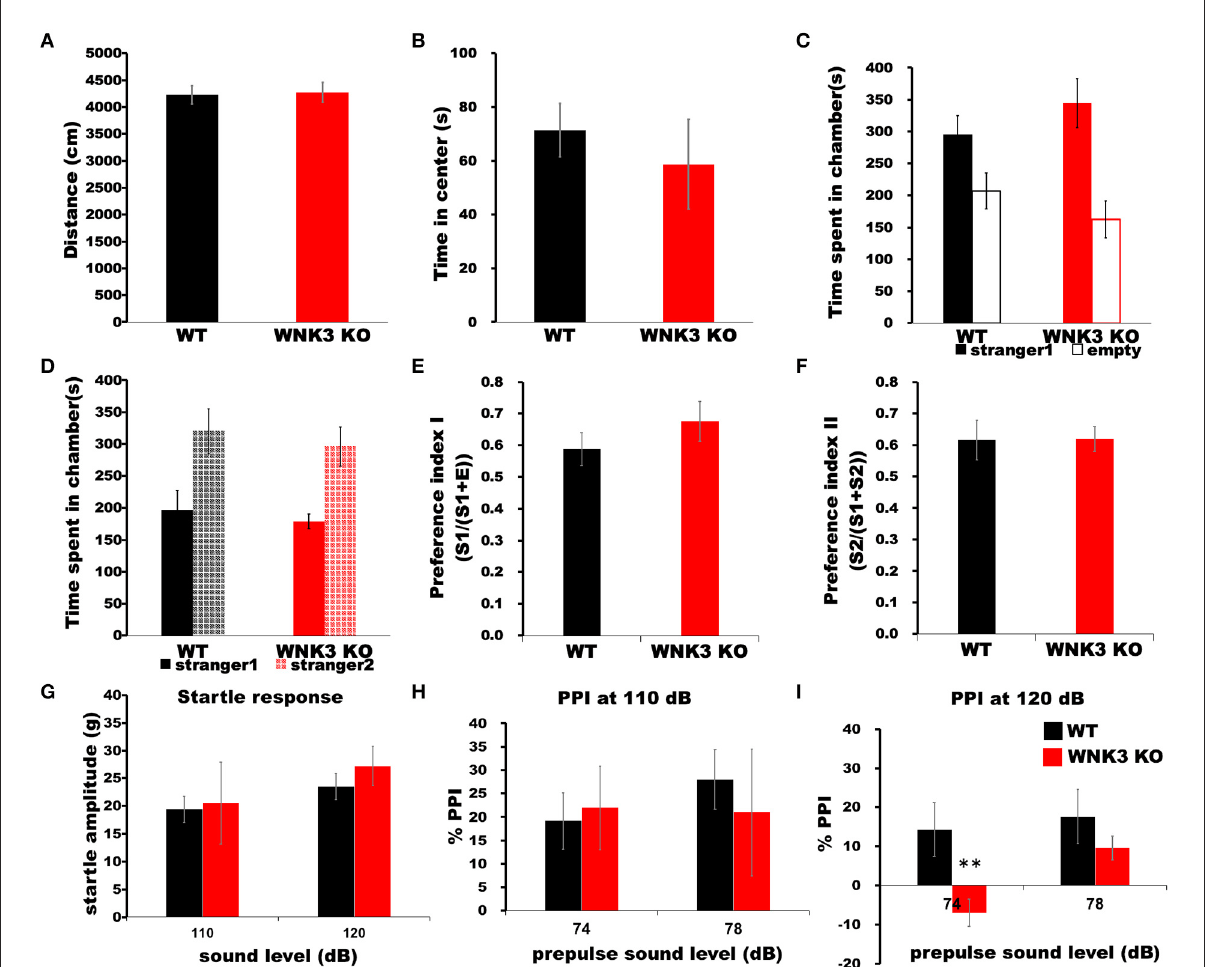
FIGURE9 WNK3 KO mice exhibit normal locomotion and social behavior but deficits in prepulse inhibition. (A) Open field test show no difference in total distance traveled (WT = 4,229.71 ± 170.84cm, n = 8 mice; WNK3 KO = 4,271.45 ± 186.62cm, n = 4 mice) indicating normal exploratory and locomotor activity. (B) Time spent in the center of the open field arena is similar between WT and WNK3 KO mice indicating anxiety levels are similar (WT = 71.39 ± 8.82s; WNK3 KO = 58.73 ± 6.13s). (C) No alterations in sociability were observed between WT and WNK3 KO mice. (D) Social novelty recognition was not affected in WNK3KO. Preference indices for (E) social interaction and (F) social memory were also not affected by WNK3 deletion. (G) Startle response amplitudes at 110 dB and 120 dB were not different between groups (H) . Percent PPI at 110